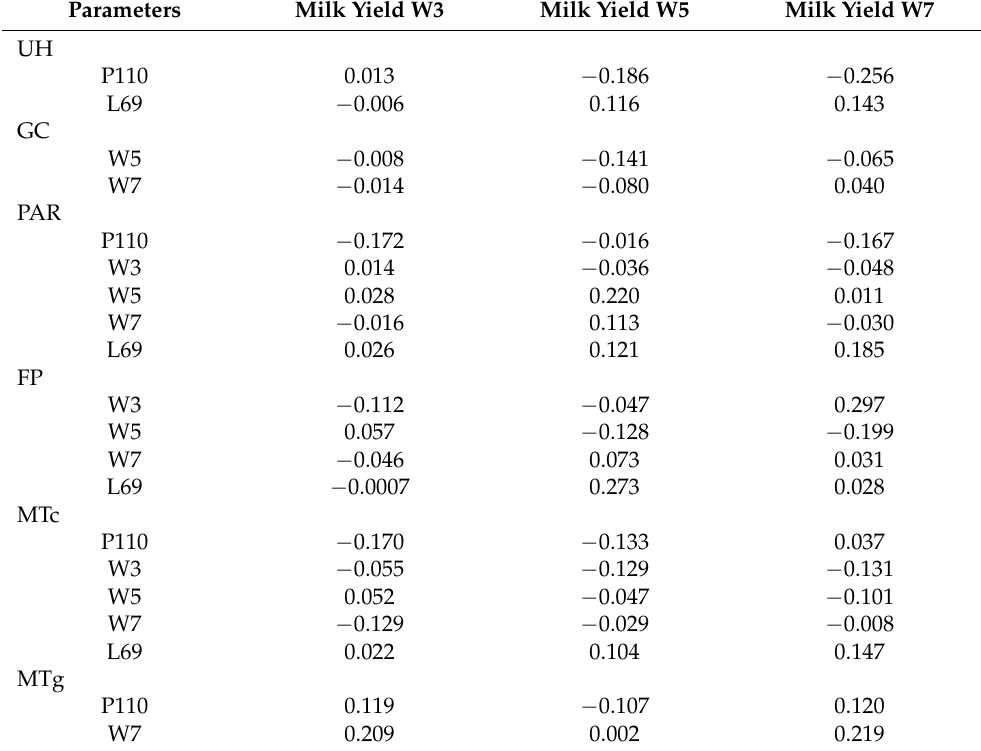
Table A2. Correlation coefficients of residuals of daily milk yield in week 3 (W3), week 5 (W5), week 7 (W7) of lactation, udder height (UH) in pregnancy (P110) and at weaning (L69), gland cistern (GC), parenchyma (PAR), fat pad (FP), total depth of the mammary gland conservative (MTc) and total depth of the mammary gland generous (MTg) at P110, W3, W5, W7, L69 per udder half. Parameters Milk Yield W3 Milk Yield W5 Milk Yield W7